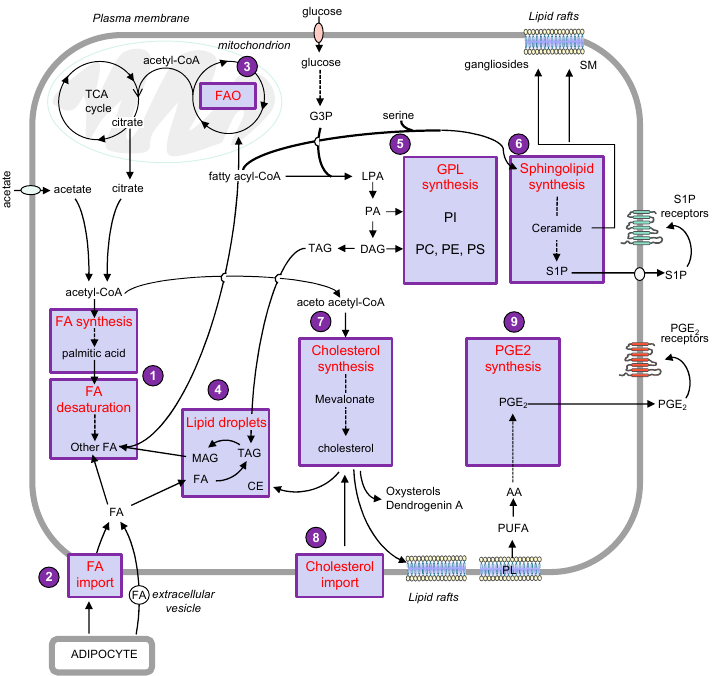
Figure 1. Schematic overview of the lipid metabolic network that regulates melanoma progression. The figure highlights the lipid pathways that are mostly altered in melanoma cells: ( 1 ) the de novo synthesis, elongation and desaturation of fatty acids (FA), which produce the repertoire of FA with different saturation levels. ( 2 ) The import of FA from neighboring adipocytes that can fuel FA β -oxidation (FAO) in mitochondria ( 3 ) to produce energy. ( 4 ) The lipid droplets, composed of neutral lipids, i.e., triacylglycerol (TAG) and cholesteryl ester (CE), which are critical to melanoma cell aggressiveness. ( 5 ) The synthesis of glycerophospholipids (GPL), including phosphatidylcholine (PC), phosphatidylethanolamine (PE,) phosphatidylserine (PS) and phosphatidylinositol (PI), which are produced from glycerol-3-phosphate (G3P). ( 6 ) The synthesis of sphingolipids, which begins with the condensation of serine and FA-Coenzyme A conjugates. Sphingolipids and glyceroPL are precursors of lipid mediators involved in cell signaling pathways and are used to build cell membranes in order to sustain cancer cell proliferation. ( 7 ) The cholesterol biosynthesis, initiated by the conversion of acetyl-CoA to acetoacetyl-CoA, and ( 8 ) the cholesterol import from the bloodstream. Cholesterol and sphingolipids, i.e., sphingomyelin (SM) and gangliosides, are part of the lipid rafts, which act as signaling hubs in cancer cell proliferation, adhesion and migration. ( 9 ) The synthesis of prostaglandin E2 (PGE2) from arachidonic acid (AA), a long-chain polyunsaturated FA (PUFA) freed from phospholipids (PL). PGE2 and the sphingolipid metabolite S1P are secreted and act through cell surface receptors to suppress immune response and promote melanoma progression. Abbreviations: LPA, lysophosphatidic acid; MAG, monoacylglycerol; PA, phosphatidic acid; TCA, tricarboxylic